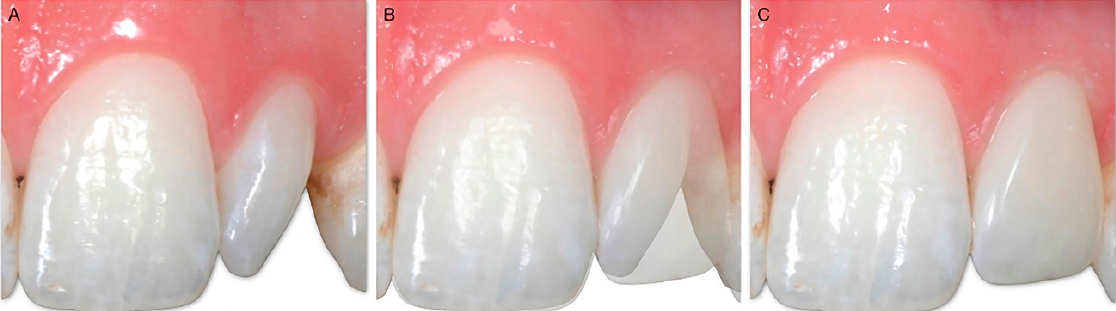
Figure 4. ( A ) A peg-shaped upper left lateral incisor. ( B ) The patient was treated using the BAIR technique. The volume of composite added to restore a shape similar to a normal lateral incisor can be seen in transparency. ( C ) The final result.